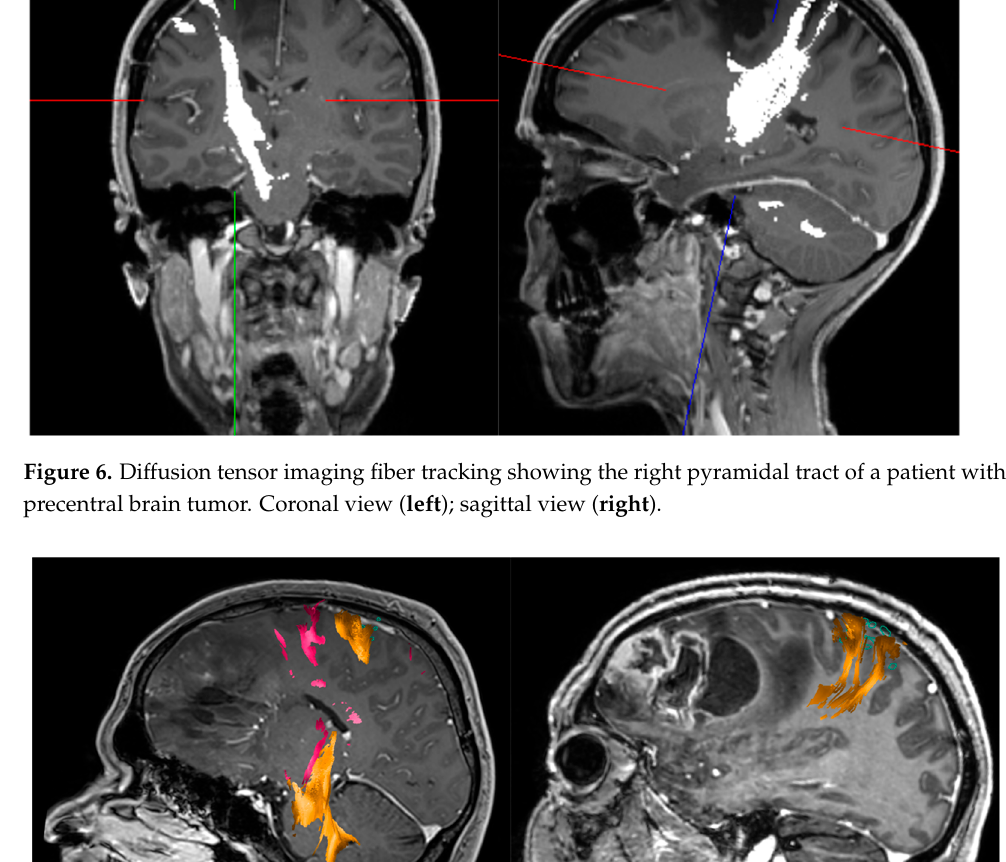
Figure 6. Diffusion tensor imaging fiber tracking showing the right pyramidal tract of a patient with precentral brain tumor. Coronal view ( left ); sagittal view ( right ).